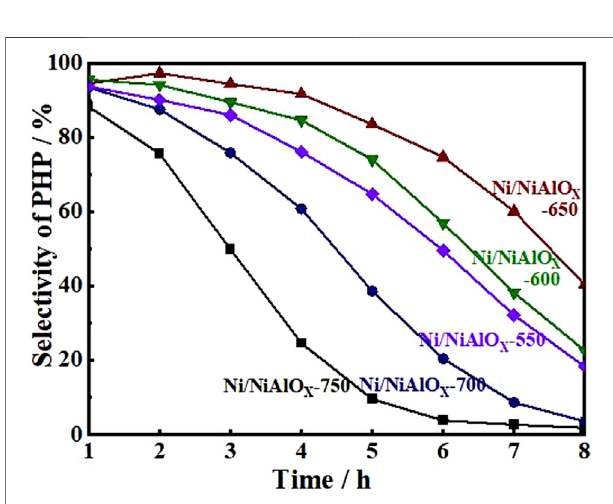
FIGURE 4 | Selectivity of perhydro-phenanthrene over Ni/NiAlO x catalysts calcinated at different